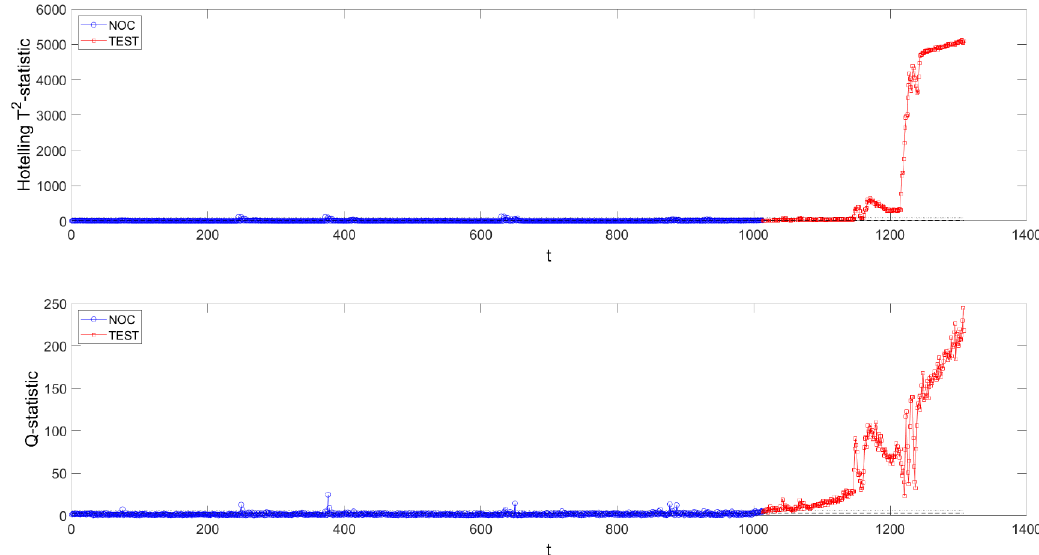
Figure 27. T 2 ( top ) and Q ( bottom ) process monitoring charts of multivariate grinding circuit data using Method III. NOC data are shown in blue and test (fault) data in red.